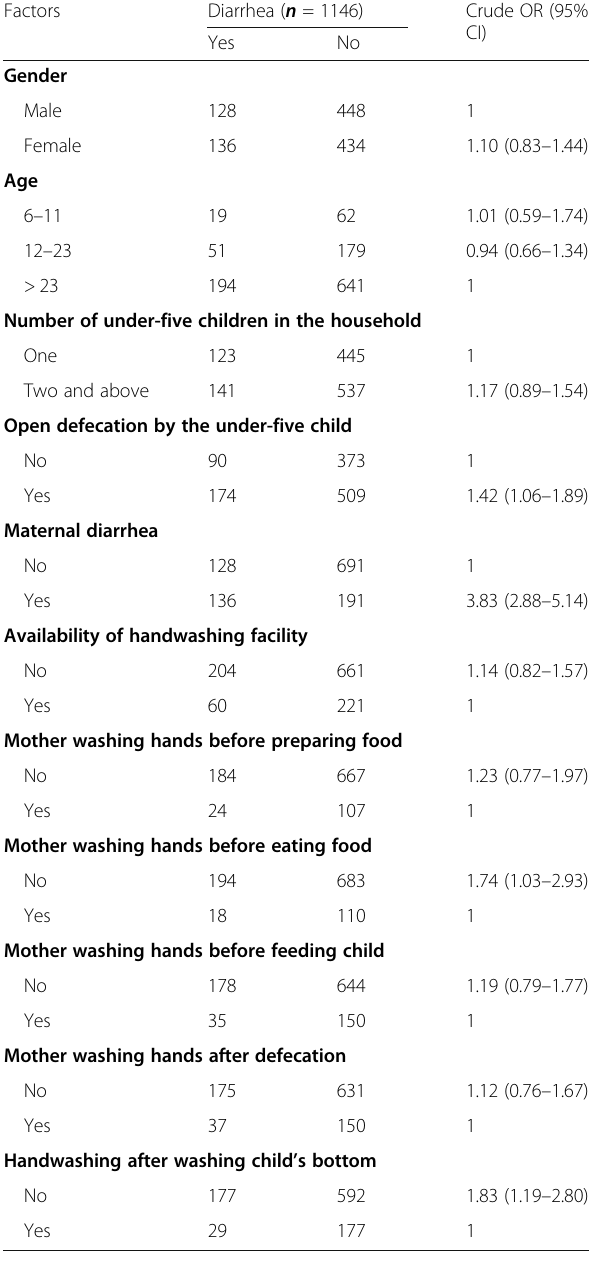
Table 3 Diarrheal disease in relation to child- and hygiene- related factors, rural Dire Dawa, Eastern Ethiopia,